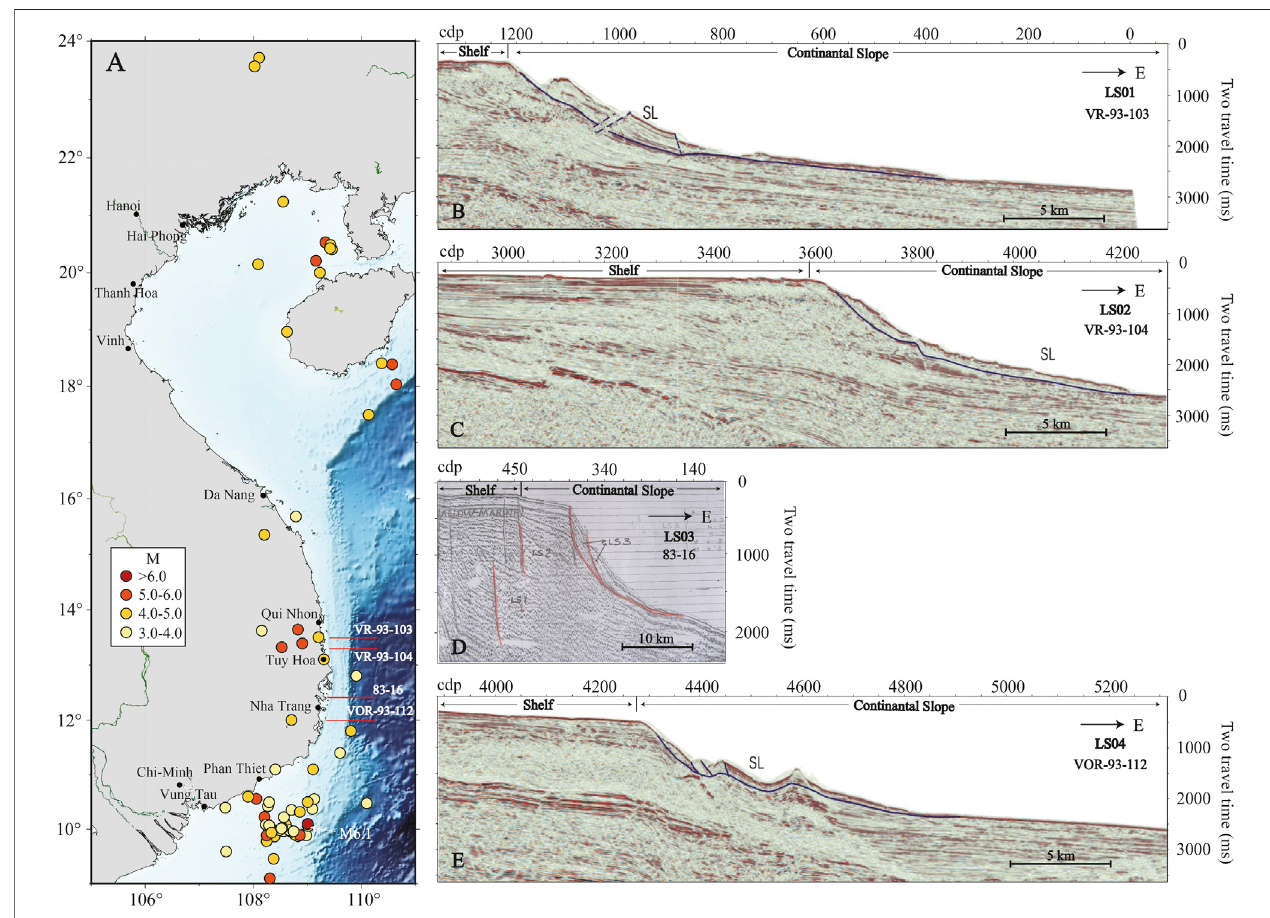
FIGURE 2 | (A) Earthquake catalog and pro fi les of western SCS. Dots : earthquakes [data from NCEDC, https://ncedc.org/cgi-bin/catalog-search2.pl, Nguy ễ n H ồ ng Ph ươ ng (2017), Phuong and Truyen (2015)]. Yellow dots : cities of Vietnam. Blue lines : seismic pro fi les. (B – E) : seismic pro fi les of LS01-LS04 (Pham Nang Vu, 2009).